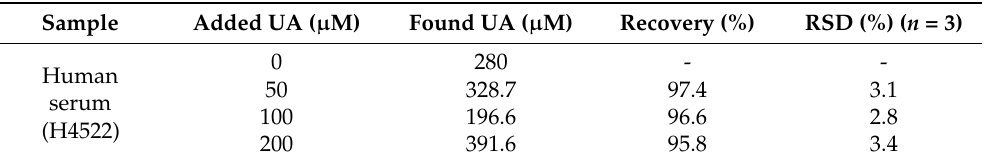
Table 2. UA analysis in human serum (H4522) sample using fabricated cobalt oxide puffy balls/ GC